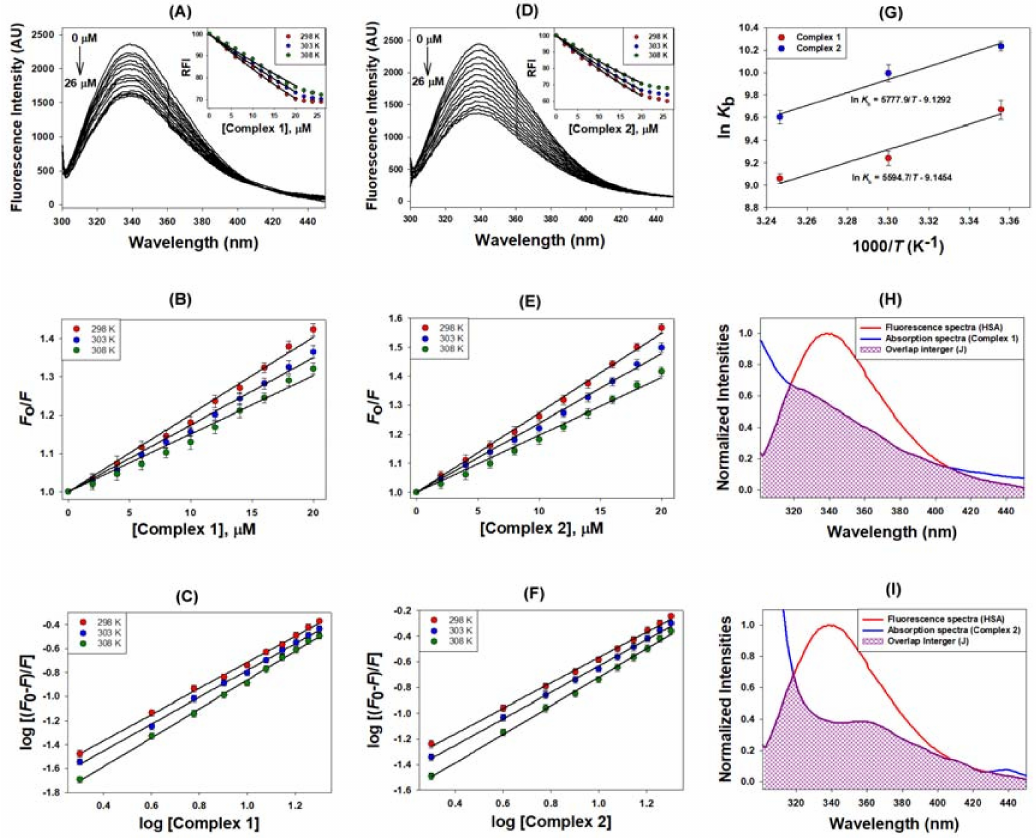
Figure 2. Molecular interaction between human serum albumin (HSA) and complexes 1 and 2 . ( A , D ) represent quenching in the fluorescence of HSA in the presence of complex 1 and 2 , respectively; ( B , E ) represent the Stern–Volmer plots of HSA-complex 1 and HSA-complex 2 respectively; ( C , F ) represent modified Stern–Volmer plots of HSA-complex 1 and HSA-complex 2 respectively; ( G ) represents the van’t Hoff plots for determining thermodynamic parameters; ( H , I ) represent FRET between HSA and complex 1 and 2 ,